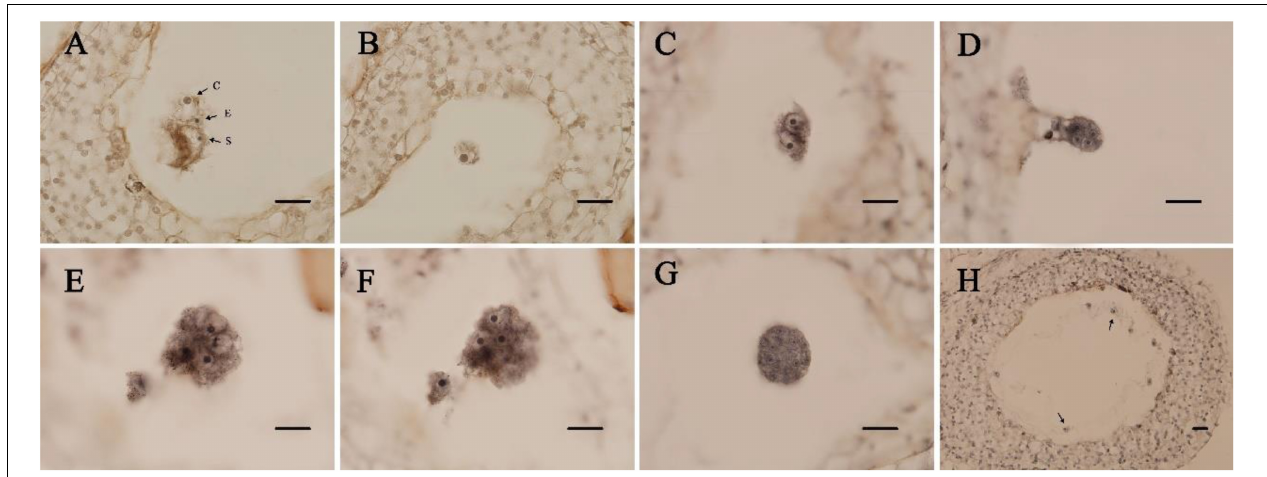
FIGURE 1 | Paraffin section of ovules in Eucalyptus urophylla. (A) Central cell (c), egg cell (e), and persistent synergid (s); (B) zygote; (C) two-cell proembryo; (D) four-cell proembryo; (E,F) eight-cell proembryo; (G) multicellular embryo; and (H) free nuclear endosperm (bar = 200 µ m).